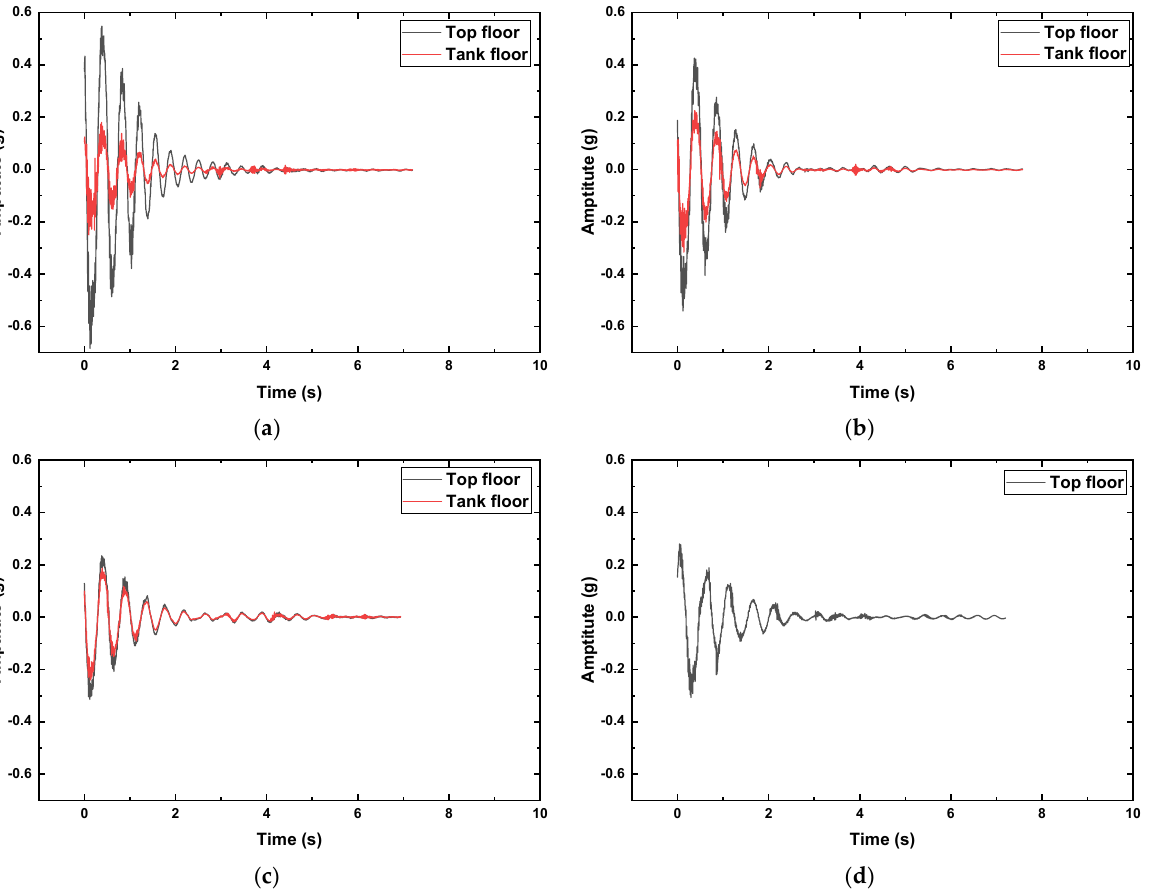
Figure 5. The accelerations when the water tank with a water level of 2 cm is placed on each floor of the structure. ( a ) 2nd floor; ( b ) 3rd floor; ( c ) 4th floor; ( d ) 5th floor.